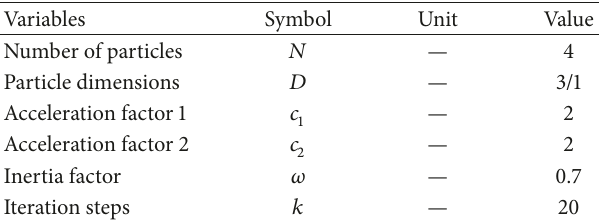
Table 2: Initial parameter settings of PSO